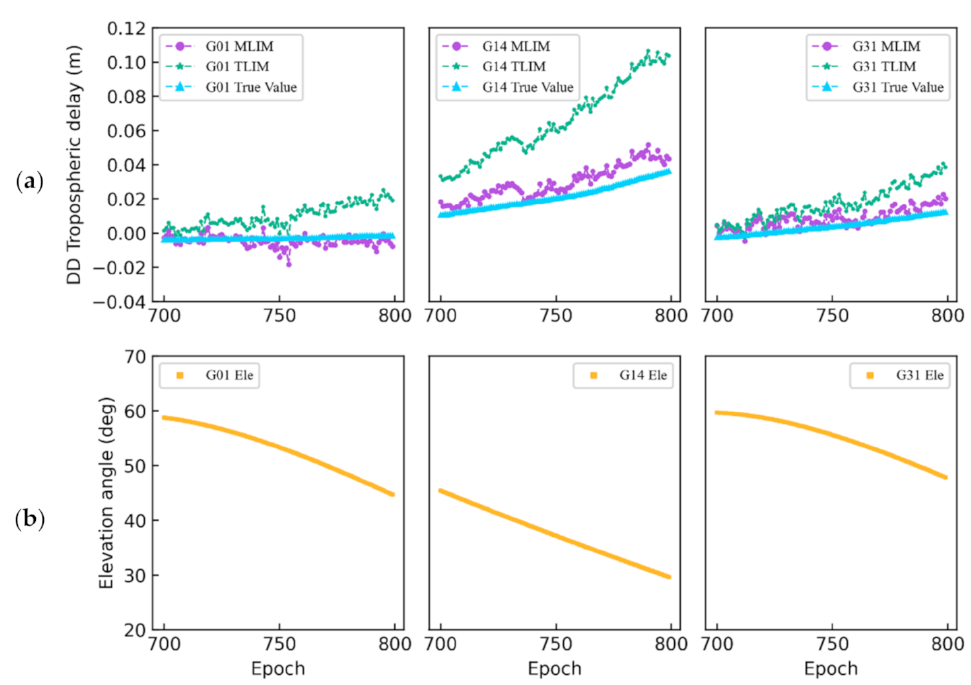
Figure 8. The DD tropospheric delay obtained by different methods ( a ) and elevation angles ( b ) for satellites G01, G14, and G31 at the rover station P225.